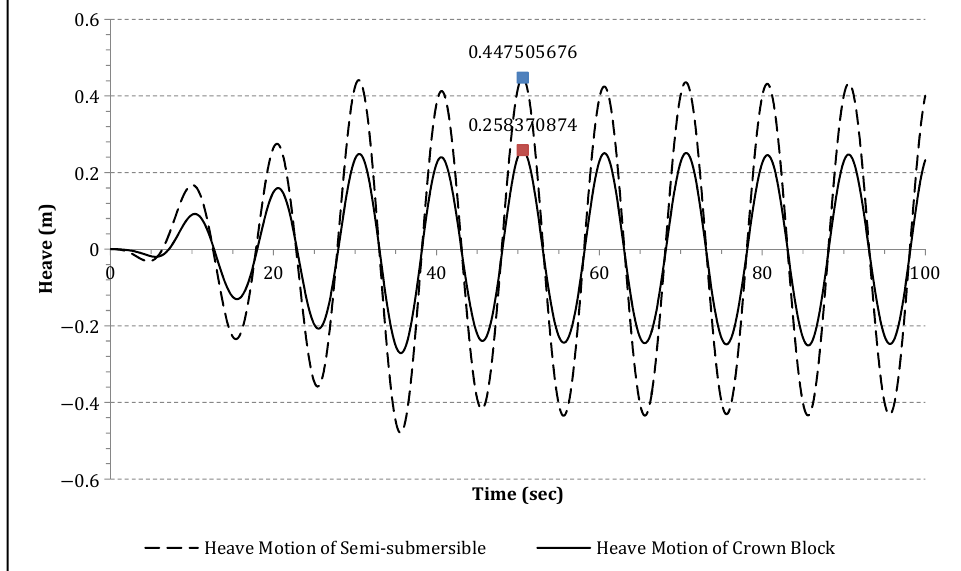
Figure 17. Heave motions of the semi-submersible and crown block for a 16.550 × 1.0-m 3 APV.